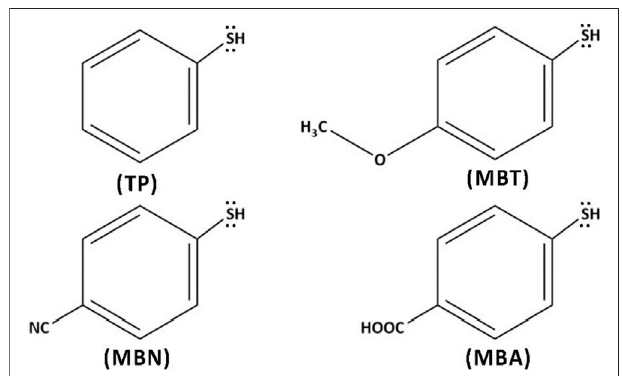
4-mercaptobenzoic acid (MBA).